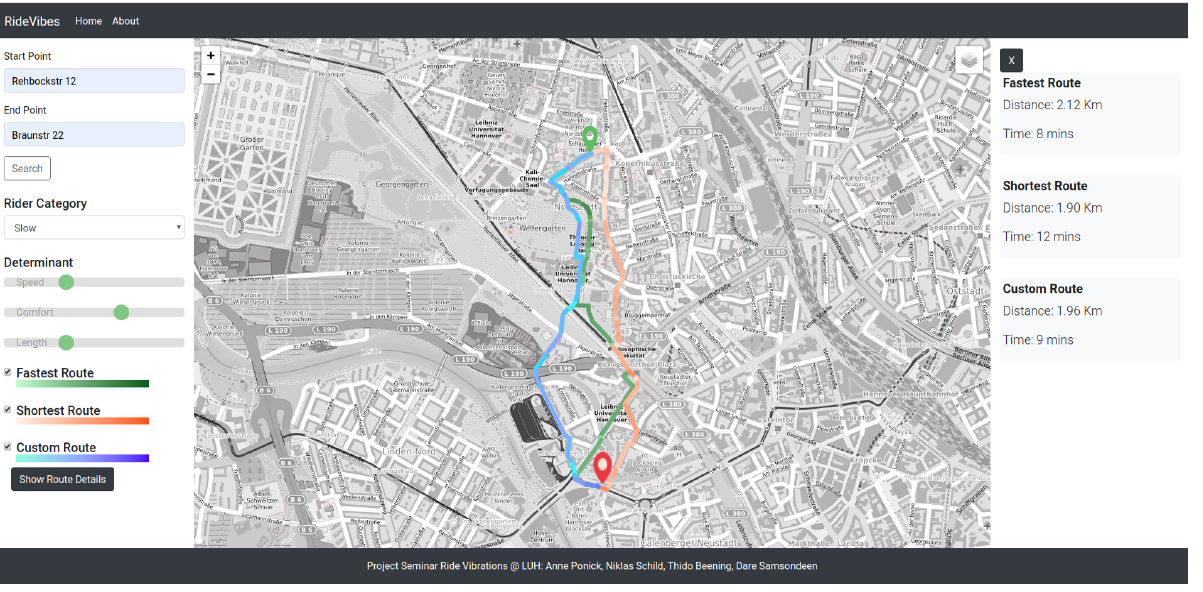
Figure 9. The routing service is offered on the website https://webmap.ikg.uni-hannover.de/ridevibesweb/ . Source of basemap: